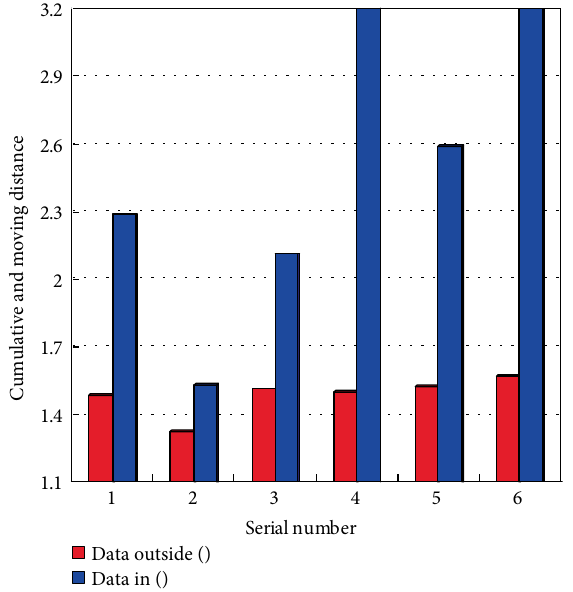
Figure 11: A comparison chart of Δ𝑋 sum when there are two obstacles.